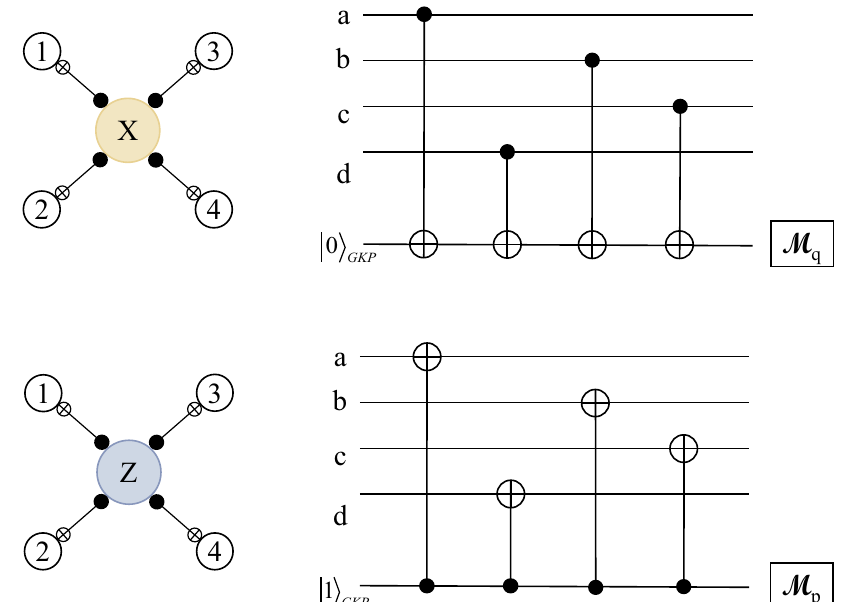
Fig. 4 Stabilizer calibration circuit. The light yellow in the surface-GKP code indicates that the calculated ground state corresponding to the (cid:3) (cid:4) (cid:3) X -type stabilizer is the 0 gkp stabilizer measurement line, and light blue indicates the calculation corresponding to the Z -type stabilizer. The (cid:3) (cid:4) (cid:3) ground state is 1 gkp stabilizer measurement line.